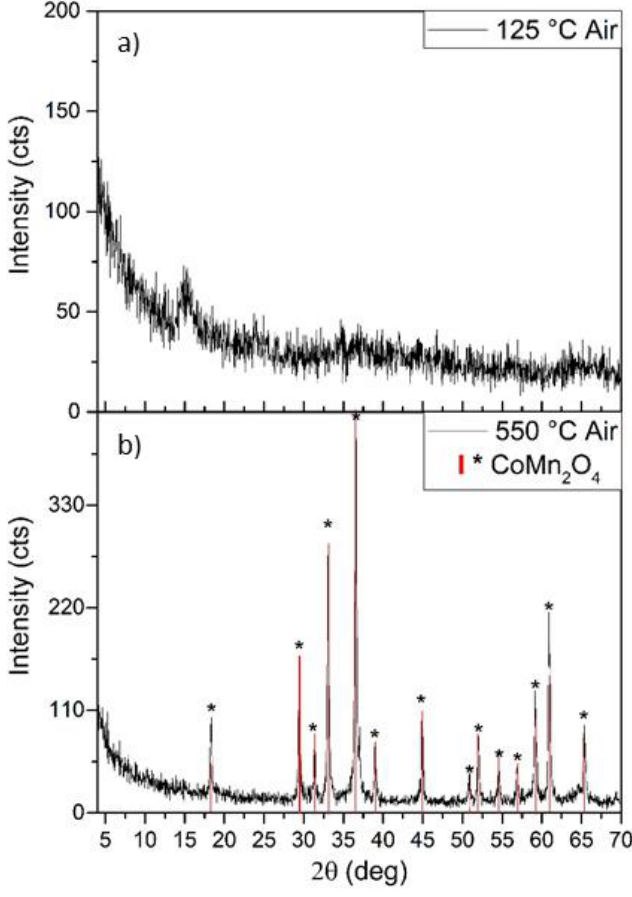
Figure 7. Powder X-ray diffractogram of the decomposition products of compound 3 Mn at 125 ( a ) and 550 °C ( b ) in 1 h in the air atmosphere.